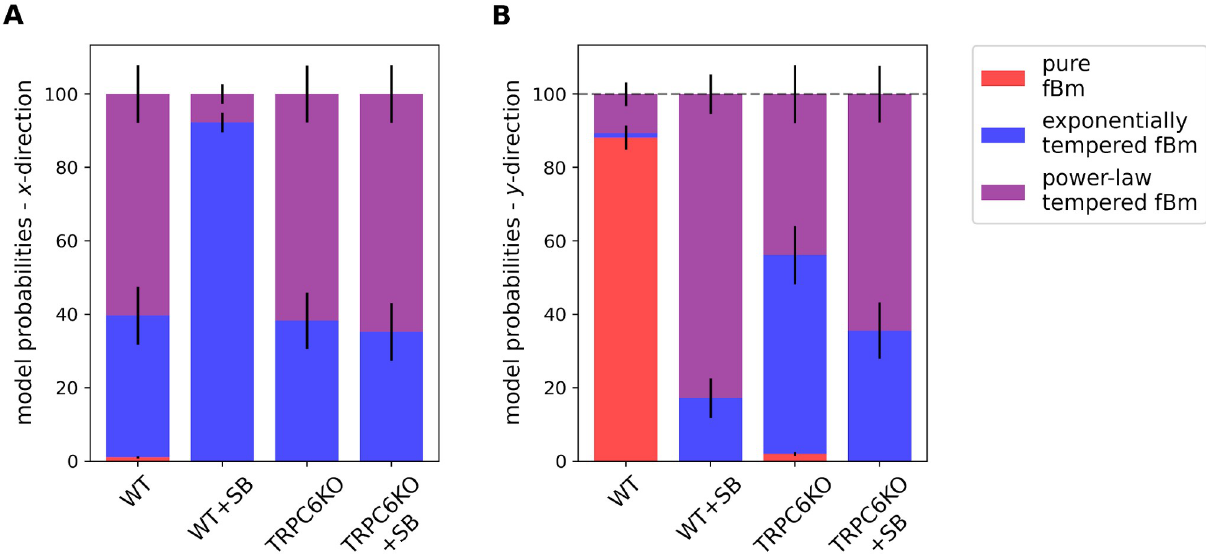
Fig 4. Model probabilities for murine neutrophils. The model probabilities for the analyzed models A—C are color coded and shown with respect to (A) x - and (B) y -direction (probabilities of model D are too small to be visualized). Wildtype neutrophils follow pure fractional Brownian motion parallel to the chemotactic gradient, whereas the dynamics of neutrophils under all other conditions is either exponentially or power-law tempered.